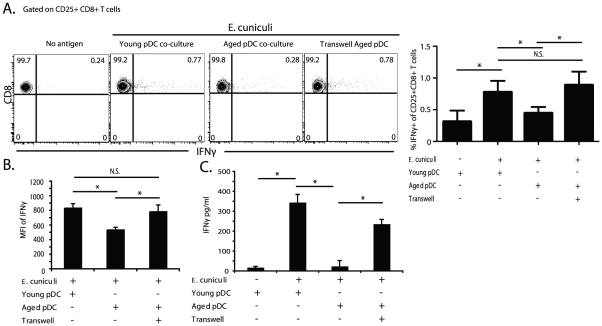
Aged pDC suppress cDC ability to prime CD8 T cells via cell contact.To determine whether aged pDC suppressed cDC ability to prime CD8 T cells in a cell contact dependent manner co-cultures were established in transwell culture plates. 2.0×106 sort purified young (8 week) splenic cDC were co-cultured with 4×105 young or aged (12 month) splenic pDC in cell contact or kept separated by a permeable membrane in the upper chamber of a transwell culture system. Co-cultures and each chamber of the transwell culture system were then stimulated at a 1∶1 ratio with irradiated E. cuniculi spores for 12 hours. After stimulation cDC were re-sorted to remove pDC and extracellular E.cuniculi spores. Subsequently, 2.5×105 young cDC were transferred to DC depleted CD11c DTR transgenic mice (DT 100 ng 6 hours). Four days later splenocytes of recipient mice were harvested, restimulated for 18 hours with E. cuniculi and assayed for the percent of activated CD25+ CD8+ T cells expressing IFNg+ by flow cytometry. (A) Representative contour plots show frequency of activated CD25+ CD8+ T cells that are IFNg+ in splenocytes from recipient mice. (A) Bar graphs of the percent IFNg+ of CD25+CD8+ T cells show mean ± SD from 2 separate experiments. (B) Bar graphs show the mean ± SD MFI of IFNg in activated CD25+ CD8+ T cells of recipient mice. Data in bar graphs in A and B were analyzed by 1 way ANOVA and Bonferroni's multiple comparison test with * p<0.05. Separately, recipient mouse splenocytes were re-stimulated overnight and IFNg in the supernatants measured by ELISA. (C) Bar graph shows mean ± SD of IFNg production by restimulated recipient mouse splenocytes. Data is representative of 2 experiments repeated separately with an n = 4 mice/group. *p<0.05 by Student's t test.